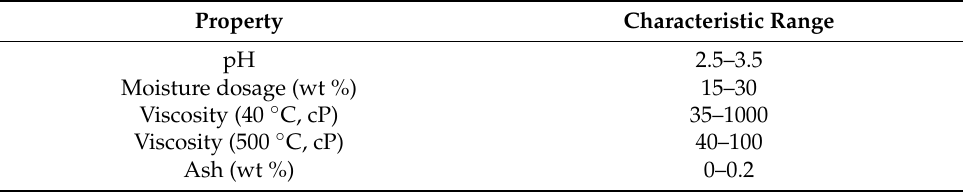
Table 1. Physical characteristics of bio-oils